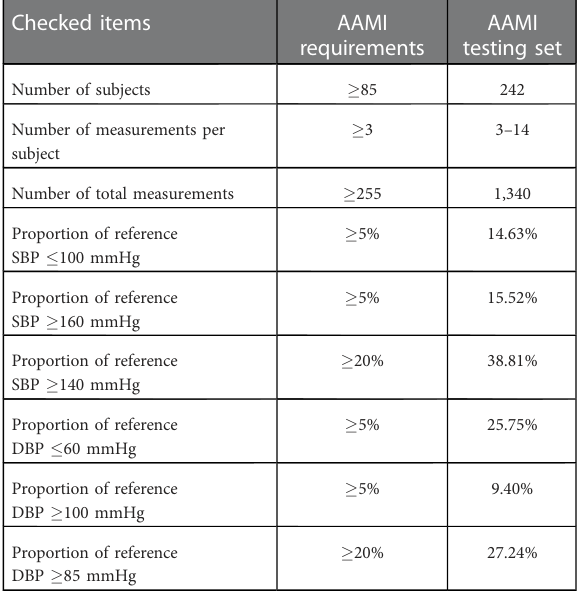
TABLE 2 AAMI standard requirements and their corresponding values for the AAMI testing set generated from the PulseDB